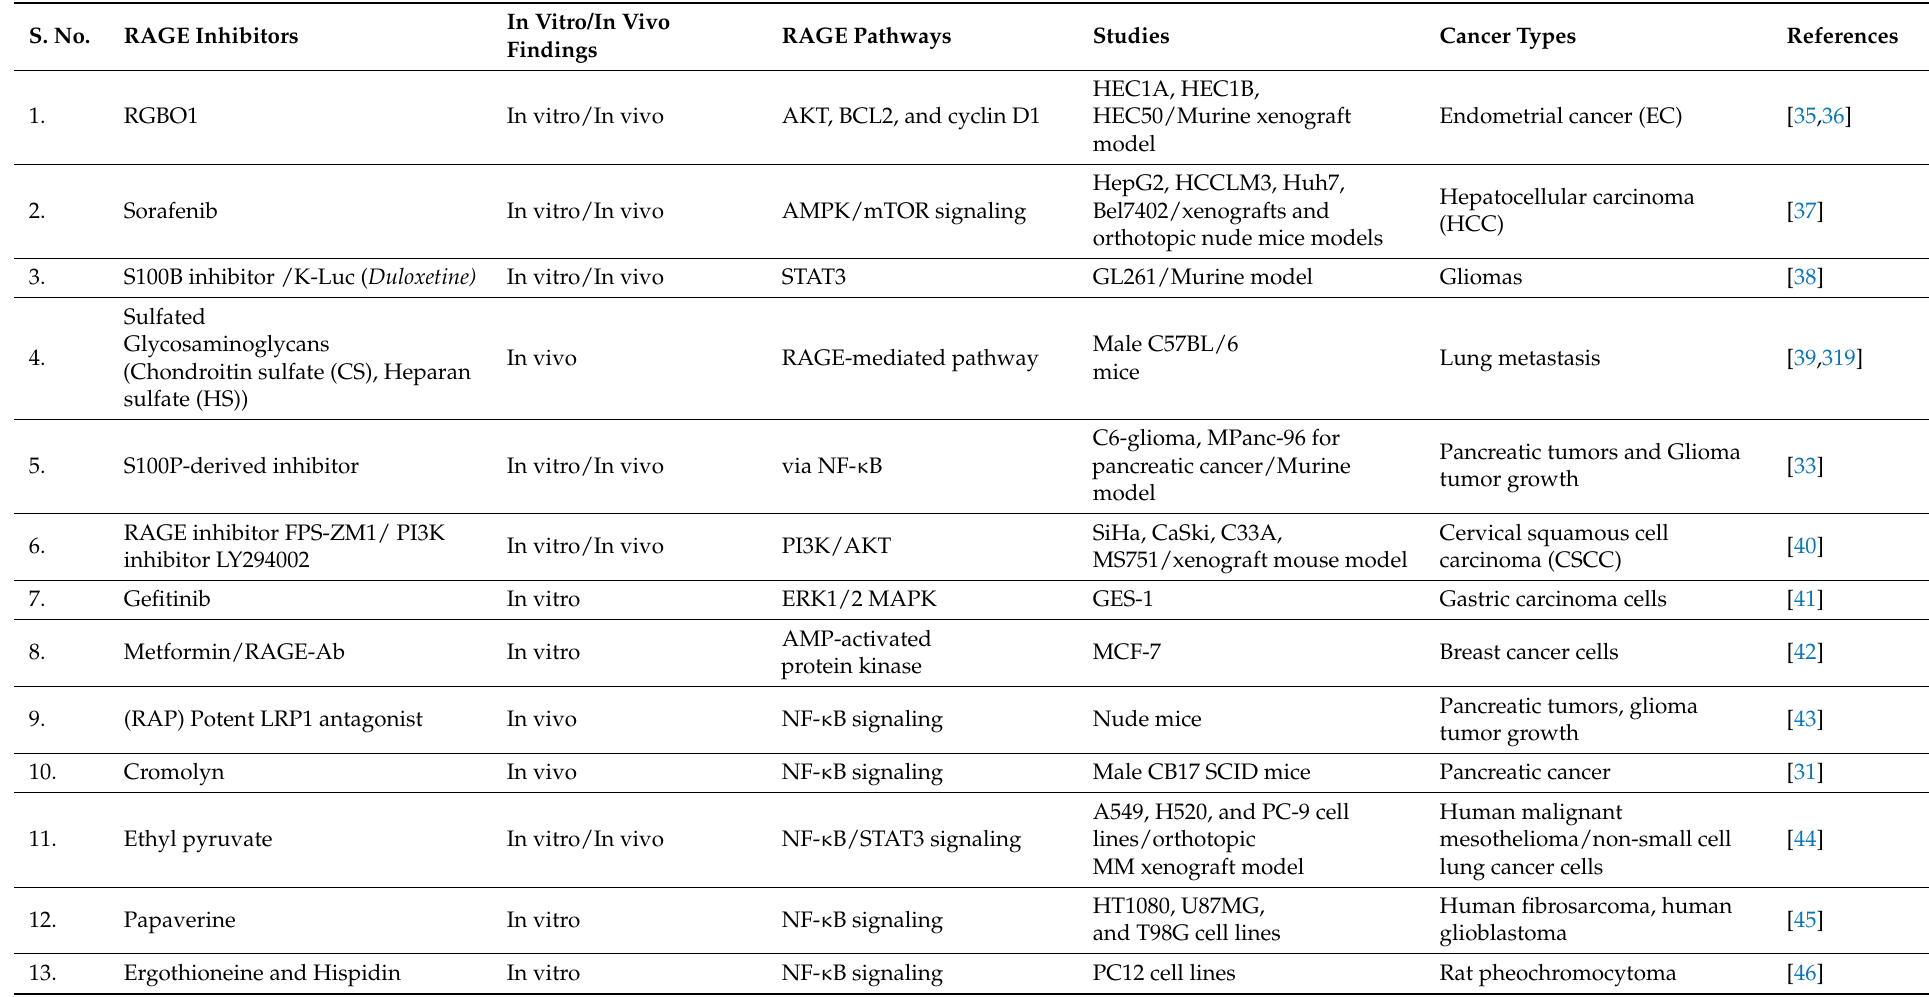
Table 2. RAGE inhibitors are designed for diverse human